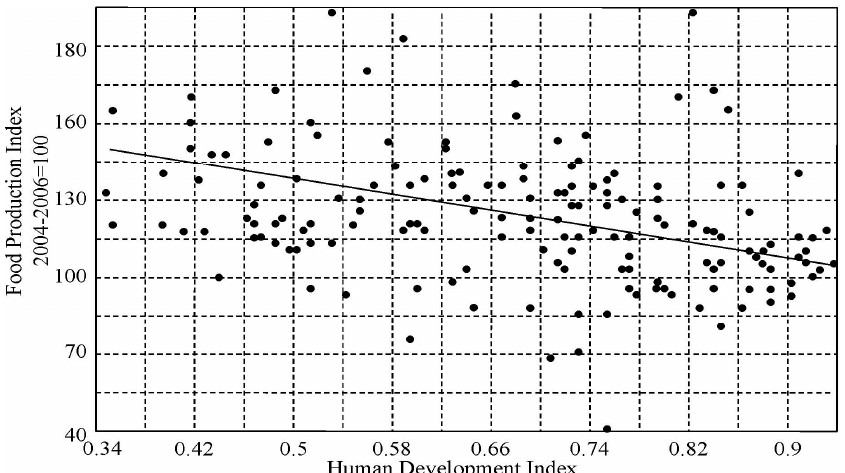
Figure 5. Birth rates and mortality dependencies on the Human Development Index adopted by the countries.